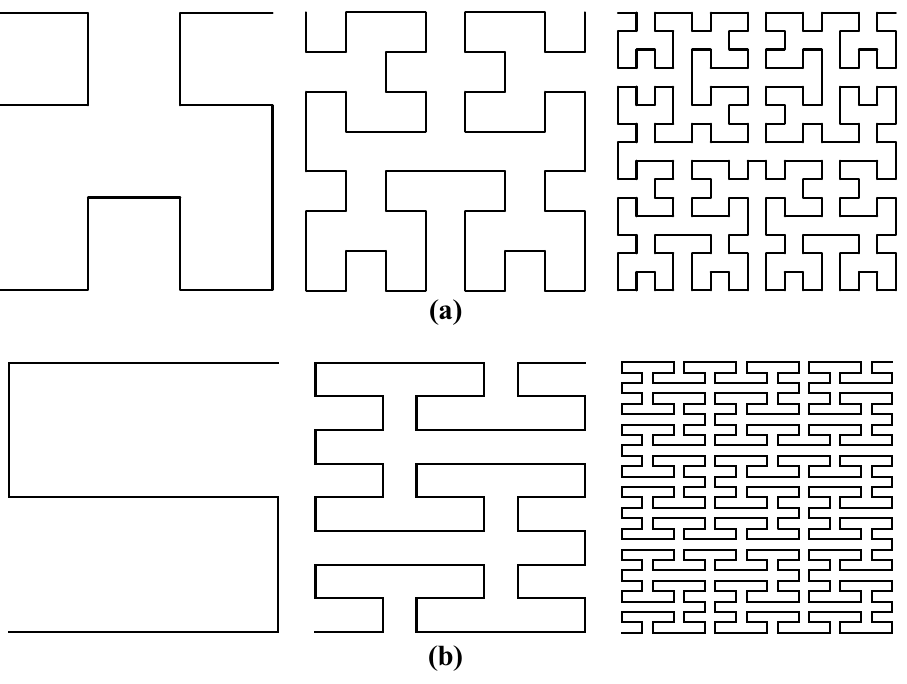
Figure 5. The first three orders of two Hilbert–Piano curves: ( a ) Hilbert–Piano curve a; ( b ) Hilbert–Piano curve